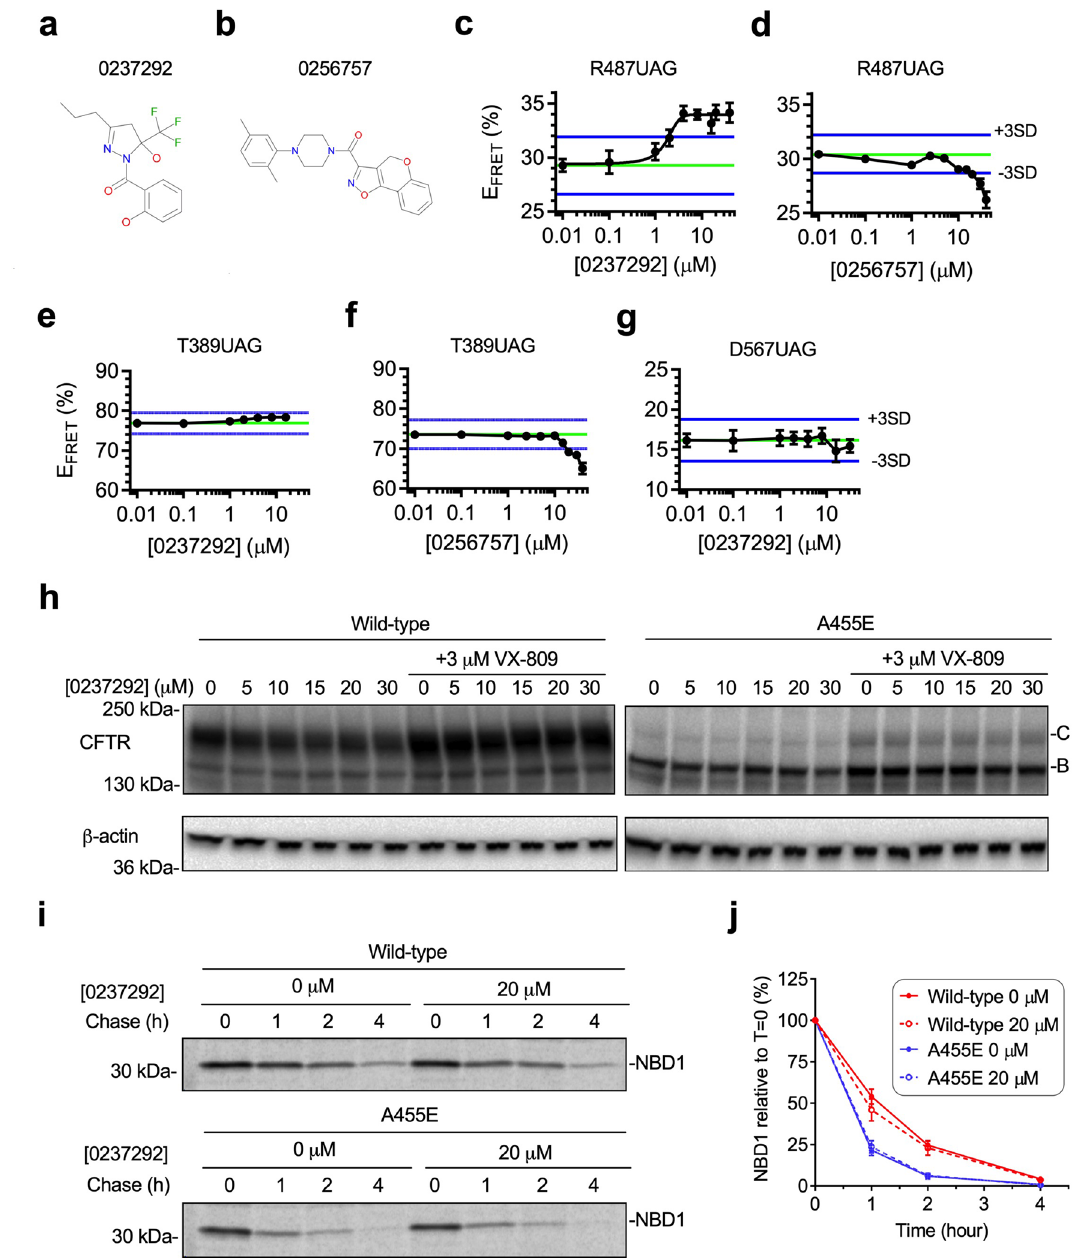
Figure 8. Hit confirmation. ( a, b ) Chemical structures of compound 023792 ( a ) or compound 0256757 ( b ). ( c – g ) Dose response results for compound 0237292 ( c , e , g ) or compound 0256757 ( d , f ) measured by solid-support FRET using A455E NBD1 RNCs with acceptor dye inserted at residue 487 ( c , d ), 389 ( e , f ), or 567 ( g ). Data are mean ± SEM, n ≥ 3 independent experiments. ( h ) Immunoblot of CFTR wild-type or A455E with 0–30 µM compound 0237292 with or without 3 µM VX-809 treatment expressed in human embryonic kidney (HEK) 293 cells showing no effect of compound 0237292 on both wild-type or A455E CFTR trafficking. Core glycosylated (band B) and mature CFTR (band C) are indicated. Uncropped blots in Supplementary Figure S15, S16. ( i , j ) Effect of compound 0,237,292 (20 µM) on stability of wild-type or A455E NBD1 in HEK 293 cells, determined by [ 35 S]Met-labeled NBD1 immunoprecipitation. Uncropped gels in Supplementary Figure S17. Graph shows percentage of NBD1 recovered relative to T = 0 (mean ± SEM, n = 3 independent